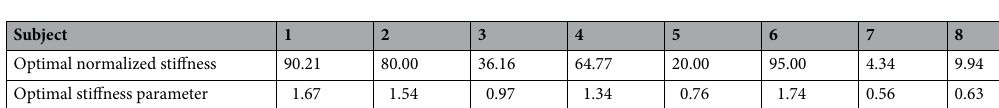
Figure 2. Cost function using symmetric foot force-time integral (FFTI) percentage evaluation results. ( A , B ) the correlation between FFTI symmetry cost and normalized measured metabolic cost at time intervals of 60–90 s ( A ) and 210–270 s ( B ). The measured and estimated cost using foot pressure symmetry (gray dots) was fitted with a linear regression (dark curve); also plotted are the confidence bounds of the data (light shade). For both time intervals, each dataset shows a statistically significant and moderately high correlation 42 .